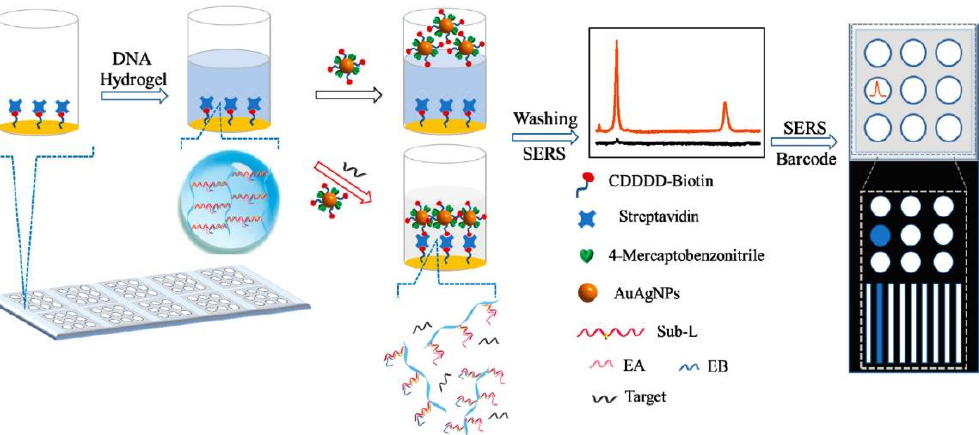
Figure 8. Schematic illustration of the preparation and application of the target miRNA-responsive DNA hydrogel-based SERS sensor array for measuring multiple miRNAs in one sample (Reprinted with permission from [91]. Copyright 2020 American Chemical